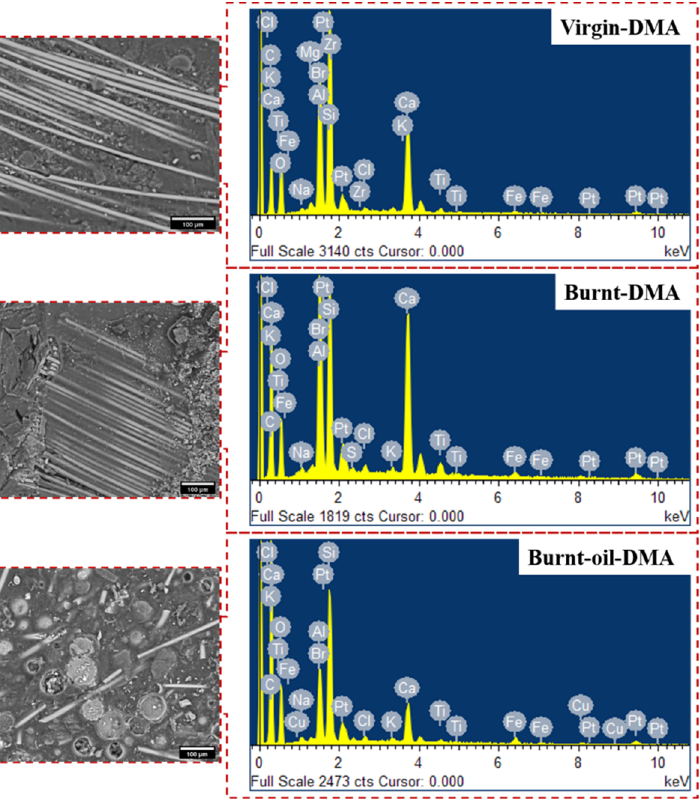
Figure 3. SEM micrographs and the accompanying elemental composition of virgin specimen (top panel), burnt specimen contamination-free (middle panel), and burnt specimen oil-contamination (bottom panel) after DMA testing.